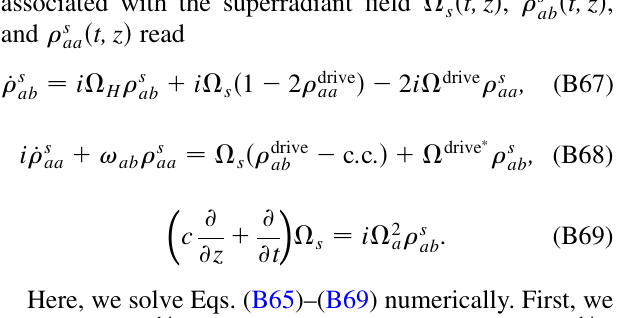
FIG. 8. Maximum gain per unit time as a function of (cid:4) d obtained by numerical solution of Eqs. (B65)–(B71) (solid line). Initially, all population is in the ground state b . In simu- ¼ 10 : 4(cid:4) , and (cid:3) is chosen to maximize lations, we take ! ab a d the gain.